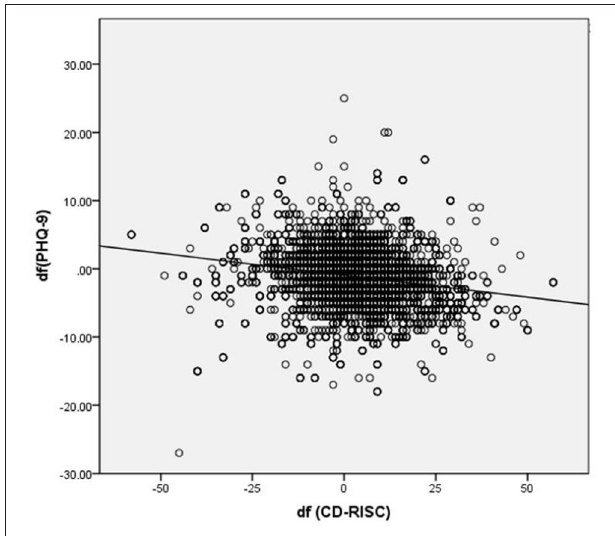
FIGURE 1 | Correlation between changes scores of CD-RISC and PHQ-9 through training ( r = − 0.238, p < 0.001). CD-RISC, the Connor-Davidson Resilience Scale; PHQ-9, the Patient Health Questionnaire-9; df, differences of post-training scores relative to baseline scores (before